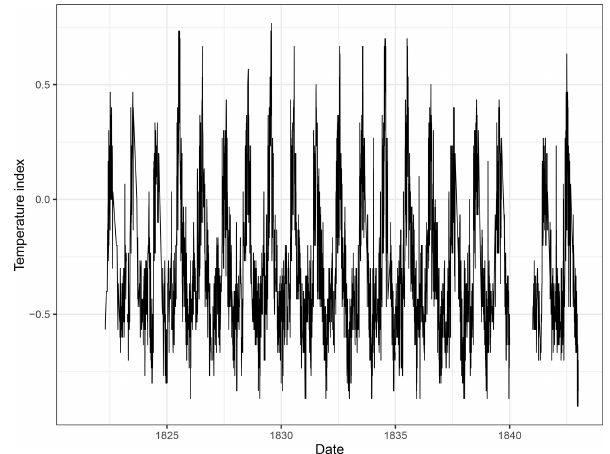
Figure 9. Three-point temperature index for the period 1816–1842. See the text for a discussion of how the index was